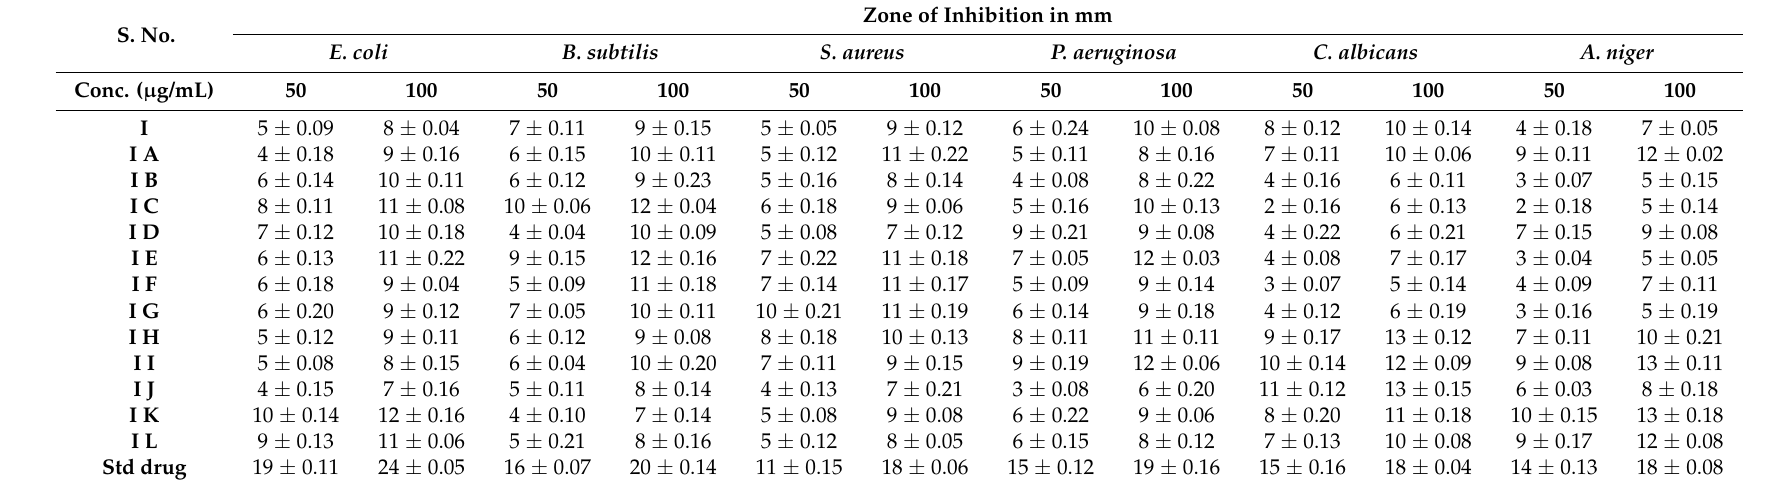
Table 2. Anti-microbial and anti-fungal activity of the α -mangostin and their synthetic